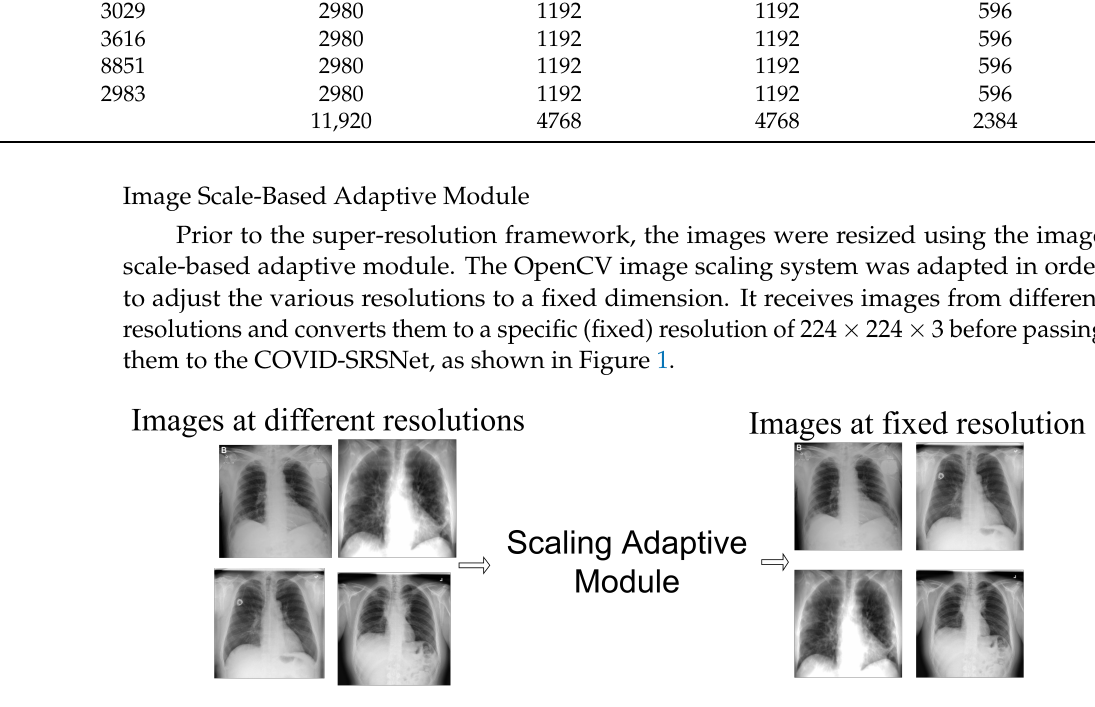
Figure 1. Scaling of images at different resolutions to a fixed resolution using image scaling adap- tive